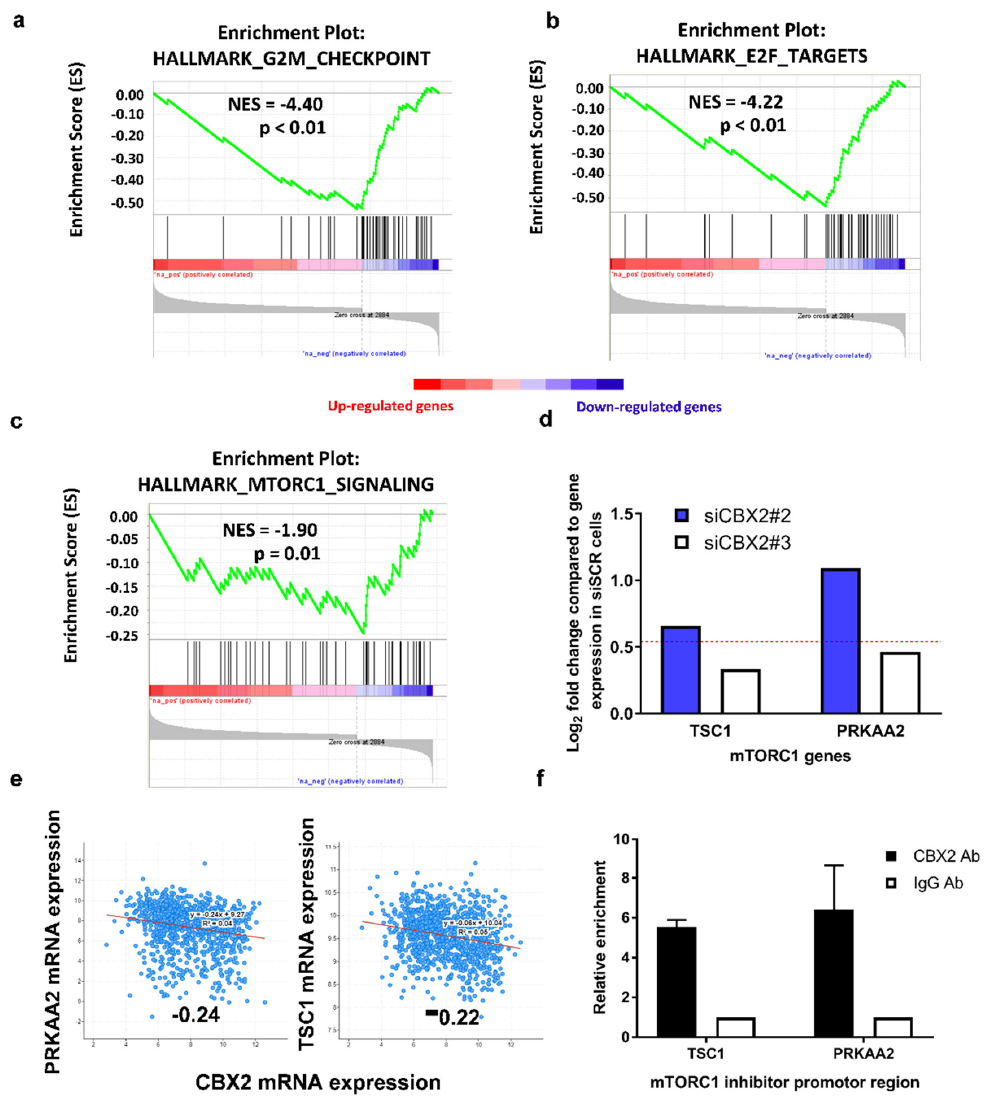
Figure 2. –The CBX2 regulated gene signature is associated with pro ‐ proliferative and oncogenic signalling pathways . ( a–d ) MDA ‐ MB ‐ 231 cells were transfected with either a non ‐ silencing control siRNA (siSCR) or siCBX2#3 and grown for 72 h (n = 3). RNA was extracted, and RNA sequencing analysis was performed. GSEA of the CBX2 ‐ regulated transcriptome (defined as genes significantly (padj < 0.05) up ( n = 2884) or down ( n = 1060) regulated 1.5 ‐ fold after knockdown compared to the siSCR control) against the “Hallmark” curated data set identified significant negative enrichment of genes associated with HALLMARK_G2M_CHECKPOINT ( a ), HALLMARK_E2F_TARGETS ( b ) and HALLMARK_MTORC1_SIGNALING ( c ) gene sets. NES = Normalised Enrichment Score. p = nominal p ‐ value. ( d ) RNA ‐ seq gene expression analysis of TSC1 and PRKAA2 in cells transfected with siCBX2#2 and #3 compared to siSCR transfected cells. Data are presented as log 2 fold change in expression. The red line represents a 1.5 ‐ fold increase (log 2 fold change = 0.585) in expression compared to siSCR transfected cells. Both genes are significantly differentially expressed in CBX2 depleted cells compared to siSCR transfected cells (padj < 0.05). ( e ) Correlation of CBX2 and PRKAA2 / TSC1 gene expression in the TCGA, PanCancer Atlas Breast Invasive Carcinoma data set. Values = Spearman co ‐ efficient. p < 0.05. ( f ) CUT&RUN qPCR analysis of promoter regions of TSC1 and PRKAA2 in MDA ‐ MB ‐ 231 cells using antibodies specific to CBX2 and isotype control (IgG). Data are an average of 2 independent experiments ± SEM and are expressed relative to the level of enrichment measured in the IgG